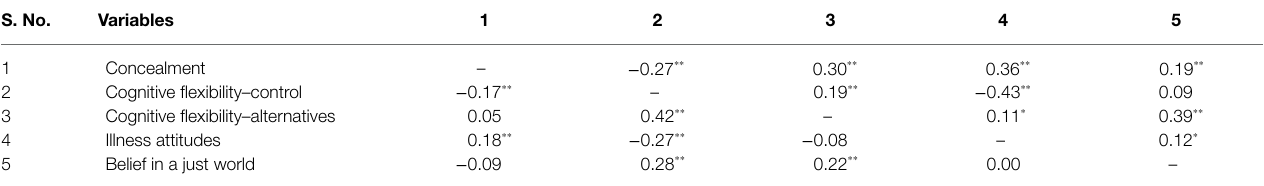
TABLE 2 | Correlation coefficients for measurement variables.